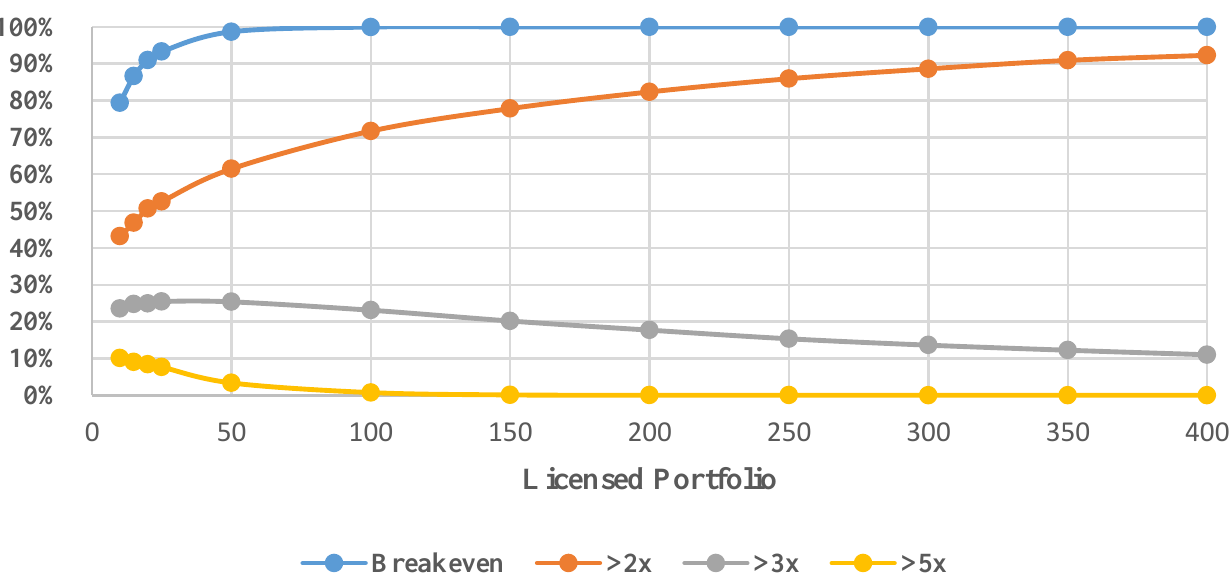
Figure 7. Portfolio return probability after 10,000 Monte Carlo simulations. Figure 7 . Portfolio return probability after 10,000 Monte Carlo simulations.